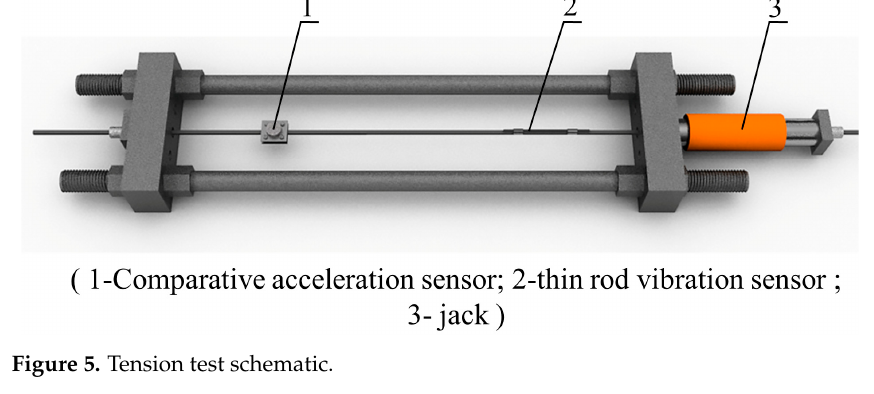
Figure 5. Tension test schematic.